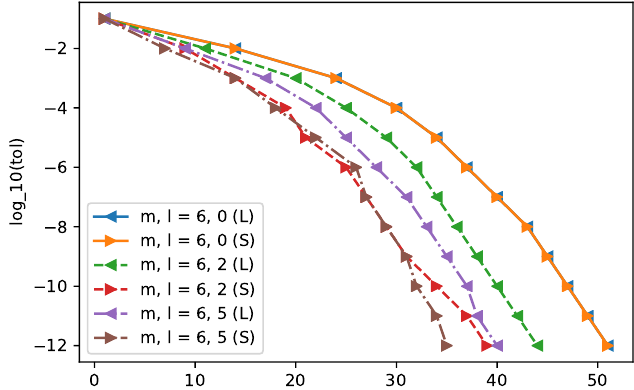
Figure 5. Convergence comparison between two different selections of eigenvalues to be deflated in EI-DR. (L) refers largest-magnitude eigenvalues, (S) refers to smallest-magnitude eigenvalues. The D1 case is used with a fixed time step 0.2